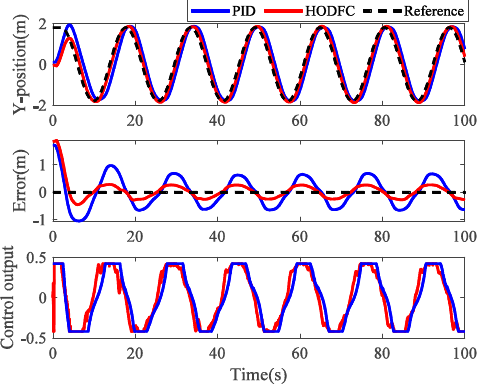
Figure 15. Experimental results of space spatial trajectory tracking in the y position. Table 4. Numerical performance metrics of the dynamic trajectory. Controller MAE ITAE